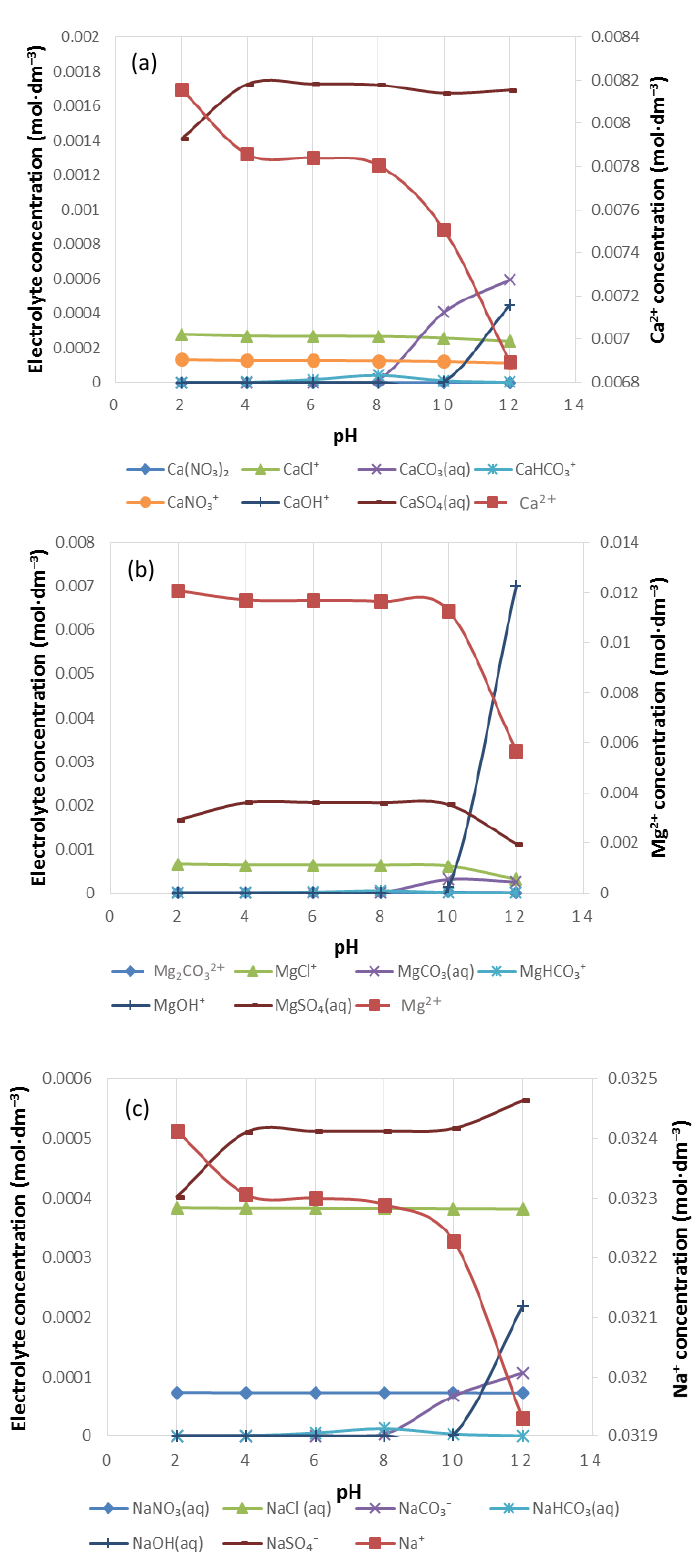
2 + , ( b ) Mg 2 + and ( c ) Na + in Figure 10. The speciation of ( a ) Ca 2+ , ( b ) Mg 2+ and ( c ) Na + in 5SPW. Figure 10. The speciation of ( a ) Ca